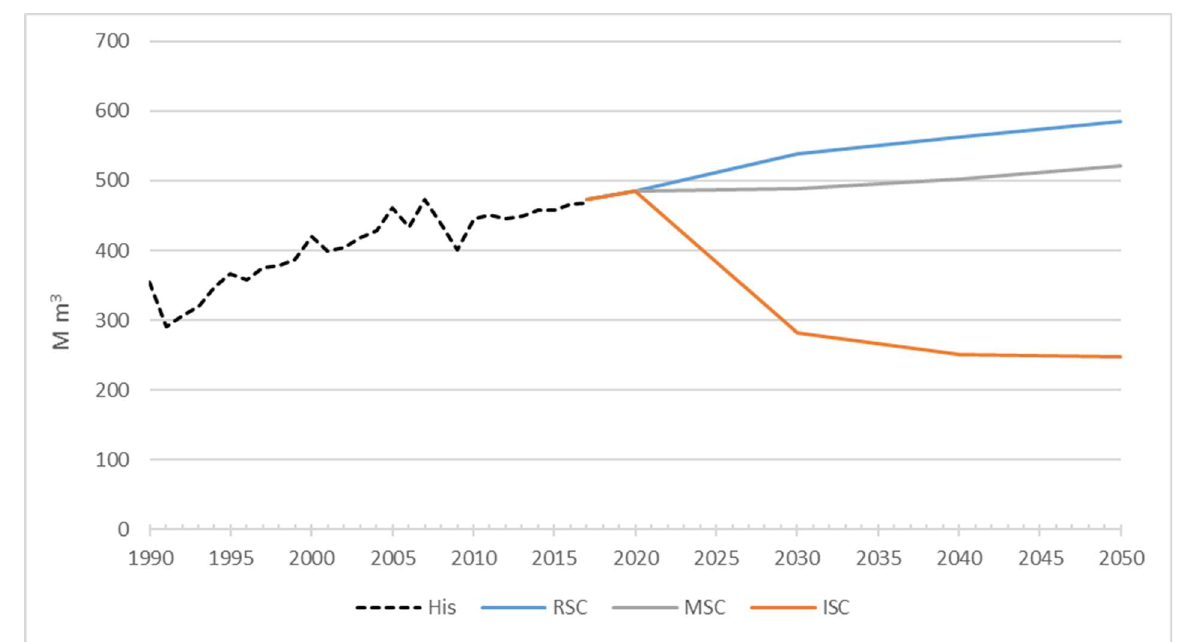
Figure 2. EU roundwood production (industrial roundwood + fuelwood) development in the reference (RSC), moderate (MSC) and intensive scenario (ISC) up to 2050 [authors’ results] as well as historical development data (His) [17].